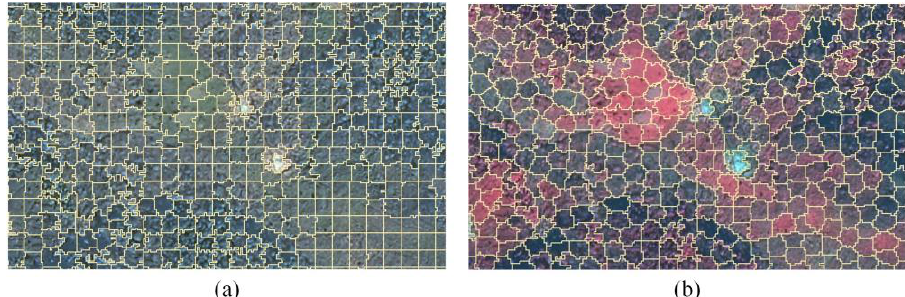
Figure 3. Comparison of superpixel segmentation using extended topology-preserving segmentation (ETPS)based on different color compositions. ( a ) ETPS segmentation based on true color. ( b ) ETPS segmentation based on standard false-color.